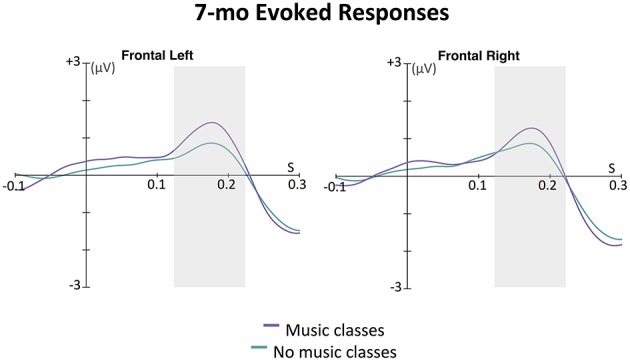
Grand average evoked responses (filters: 0.5 Hz highpass, 20 Hz lowpass) by 7-month-old infants to first tone in the 6-beat sequence averaged across eight left frontal channels and eight right frontal channels. The magnitude of the response for each group for each hemisphere was calculated as the area under the curve in a window ±50 ms around 175 ms (shown with the gray boxes); 175 ms was the time point of the largest amplitude peak in grand average of the slow positive evoked responses. In an ANOVA with infant music class enrollment as a between-subjects factor and hemisphere (left, right) as a within-subjects factor, only a main effect of music class enrollment was found. Infants who had attended music classes showed larger positive evoked responses to the sounds than infants who had not attended such classes, p = 0.048.